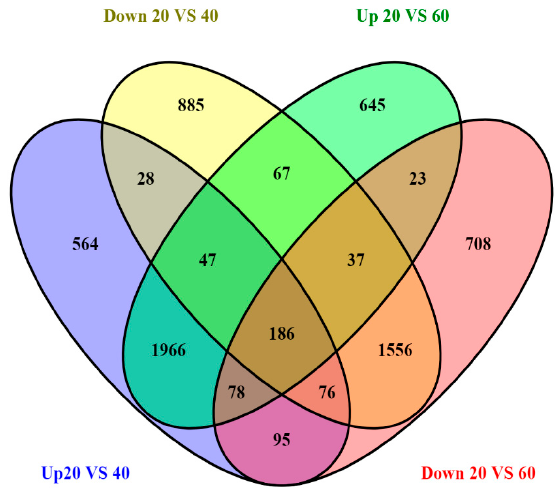
Figure 1. Venn diagram of di ff erentially expressed genes. The sum of numbers in each big circle is the total number of di ff erentially expressed genes in each comparison group, and the overlapping part is the number of common di ff erentially expressed genes among the comparison groups. Table 2. Di ff erential gene expression statistics for ( A ) 20_LV-Vs-40_LV and ( B ) 20_LV-Vs-60_LV.